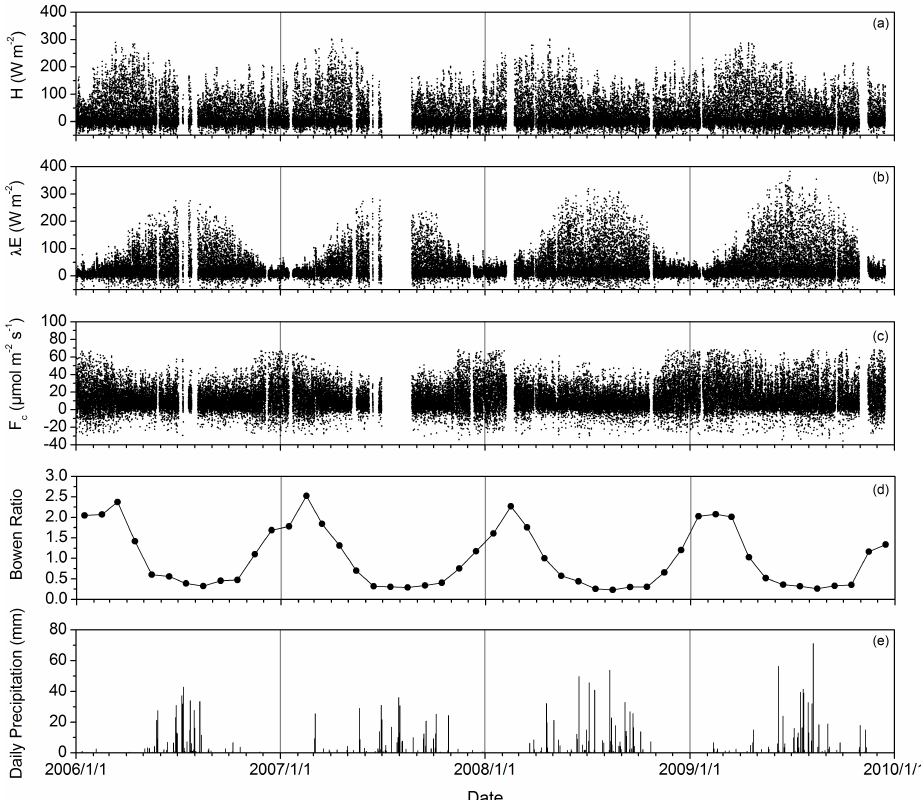
Fig. 5. The time series of sensible heat flux ( H) (a) , latent heat flux ( λE) (b) , carbon dioxide flux ( F c ) (c) at 30min interval, monthly Bowen ratio (d) , and daily total precipitation (e) during the study period. The Bowen ratio was calculated using filled data when there were large gaps in a month.